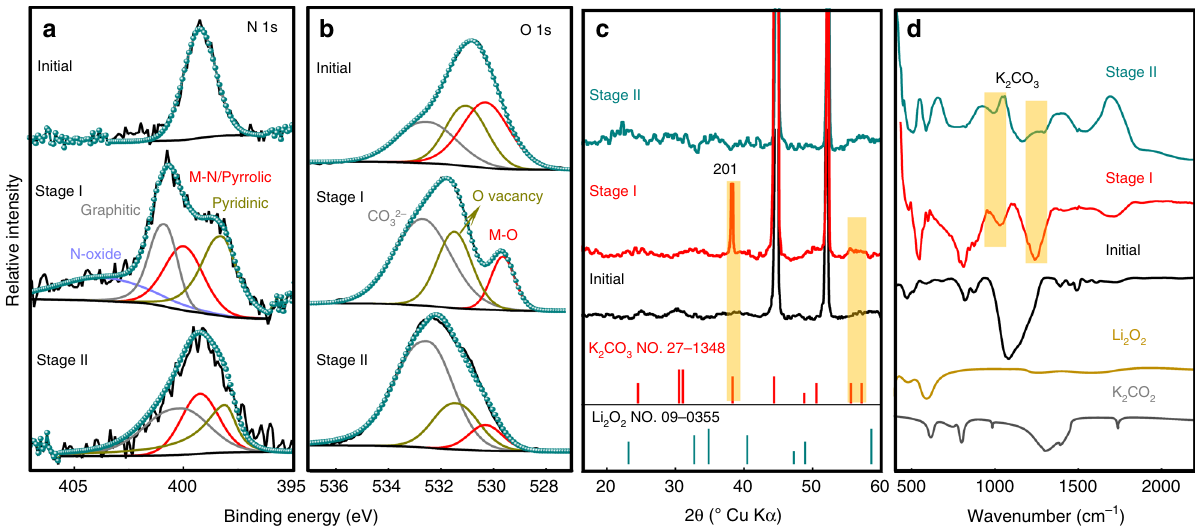
Fig. 3 Multistaged discharge products. a , b N 1 s and O 1 s X-ray photoelectron spectroscopy (XPS) spectra of initial PVP-C@LDO and discharged PVP- C@LDO at stage I and stage II. c , d XRD patterns and Fourier transform infrared spectra of initial PVP-C@LDO and discharged PVP-C@LDO at stage I and stage